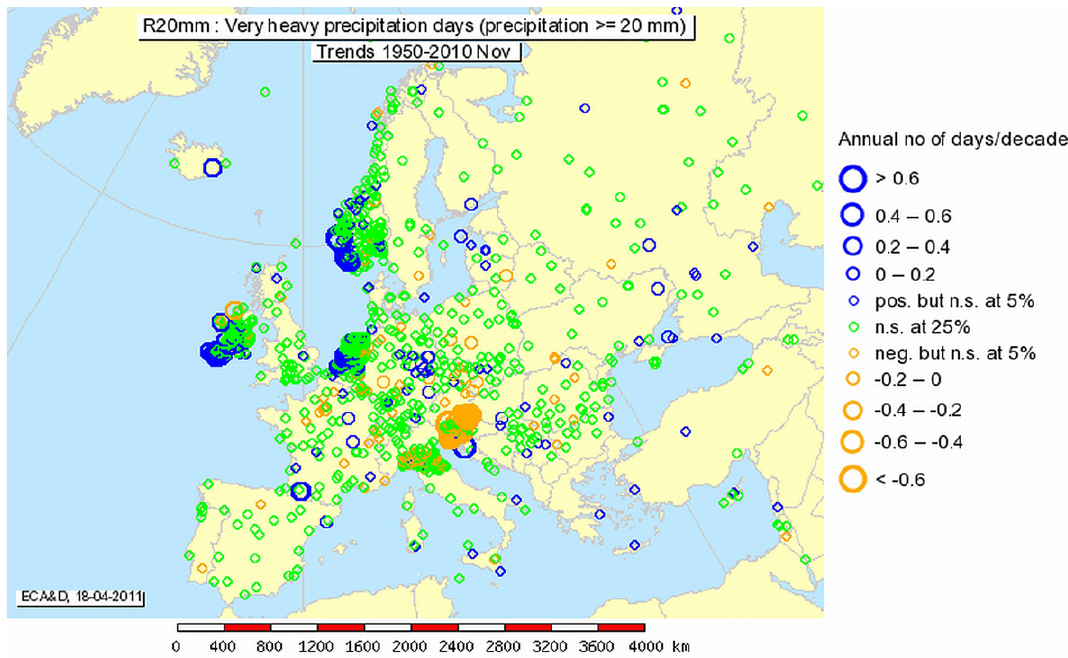
Figure 3. Example map of the trend of very heavy precipitation days ( ≥ 20mm) in November 1950–2010 (Source: ECA&D,